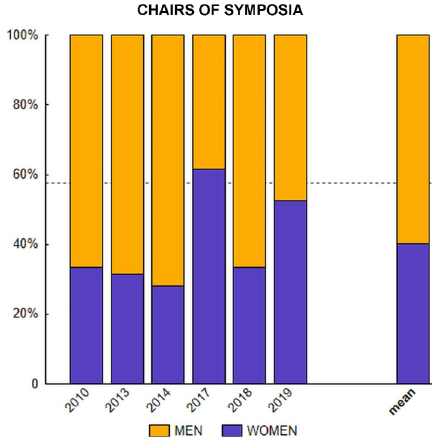
Figure 3. Chairs of symposia in six national and stand-alone meetings of the Brazilian Society of Neuroscience and Behavior (SBNeC). The dashed line indicates the mean percentage of senior women members (57.50%) between 2010 and 2019.